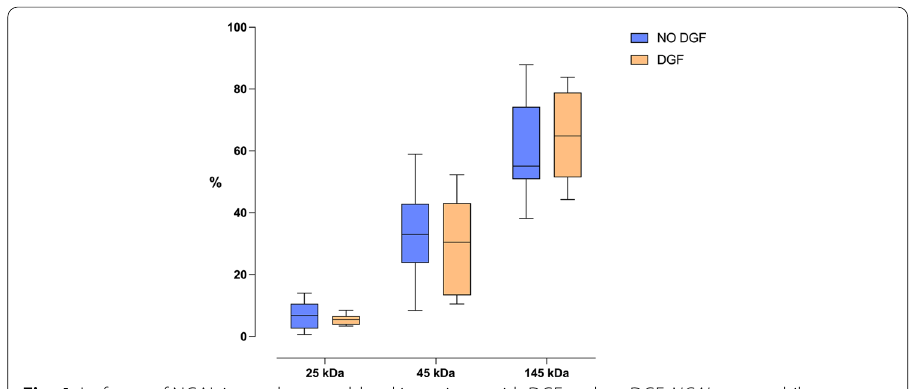
Fig. 4 Isoforms of NGAL in renal venous blood in patients with DGF and no-DGF. NGAL neutrophil gelatinase-associated lipocalin, DGF delayed graft function; The boxes represent median and interquartile-range and whiskers the lowest and the highest